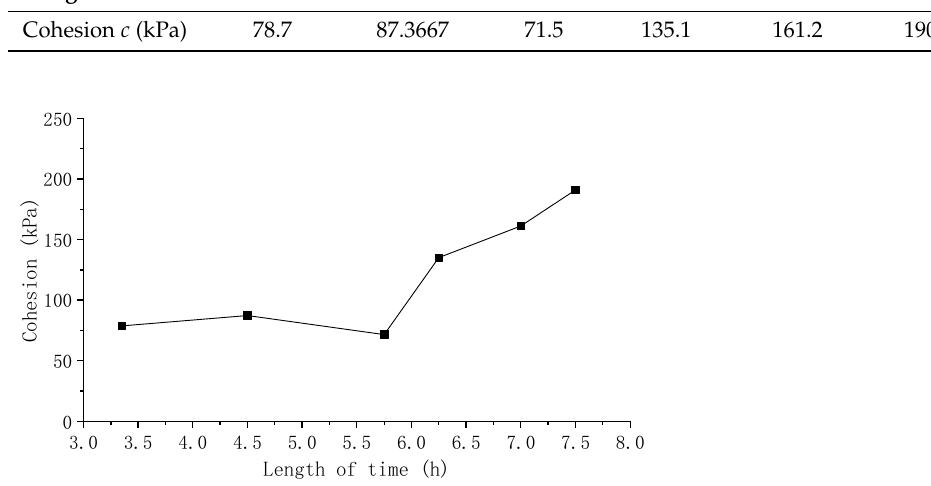
Table 6. The valid cohesion–age data obtained by the proposed regression analysis.